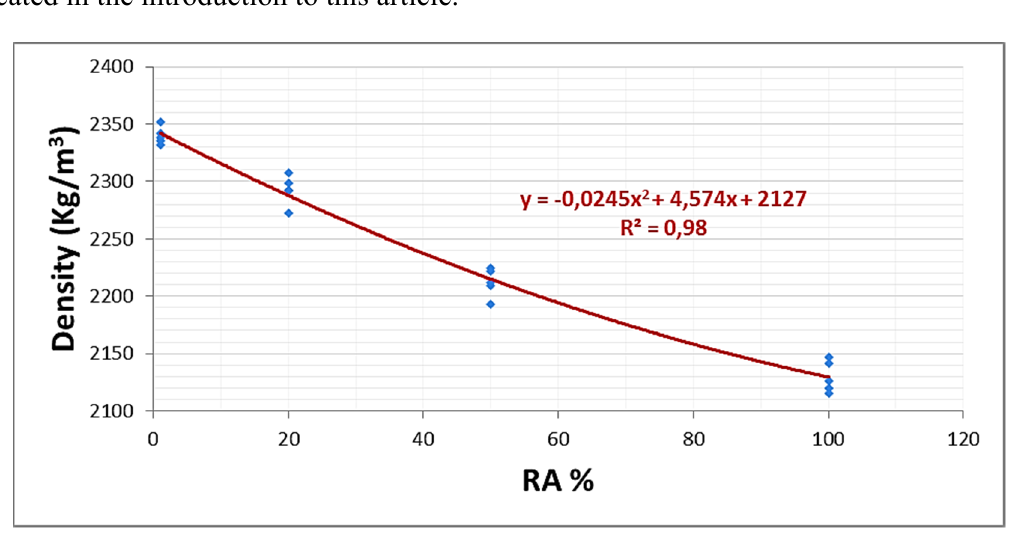
Figure 6. Relation between RA % and